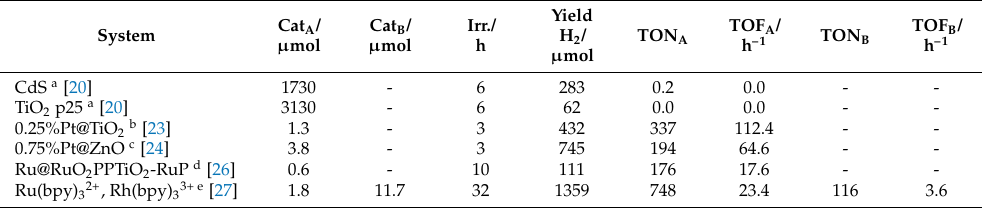
Table 1. Comparative H 2 evolution materials in the literature.